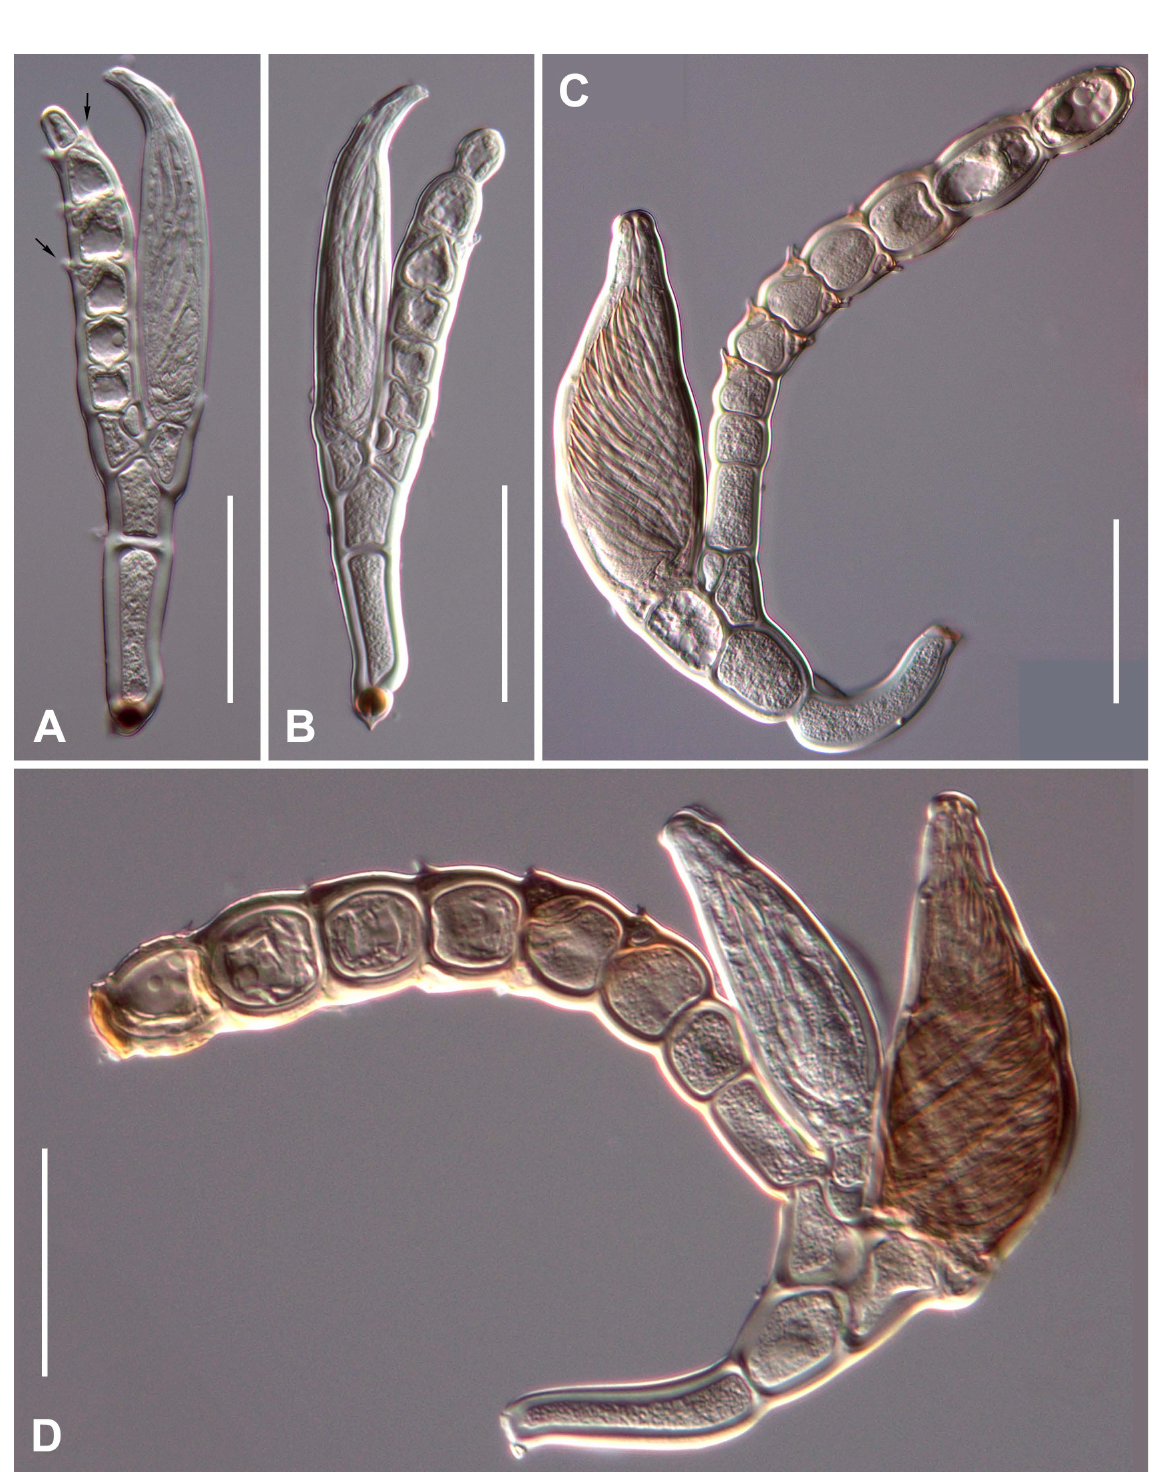
Fig. 22. Chaetarthriomyces spp. A – B . C. crassiappendicatus Scheloske. Mature thalli with labelled antheridia (arrows). – C – D . C. spiralis Santam. Mature thalli. Scale bars: 50 µm. Photographs from slides ZMUC C-F-123215 (A–B), ZMUC C-F-123214